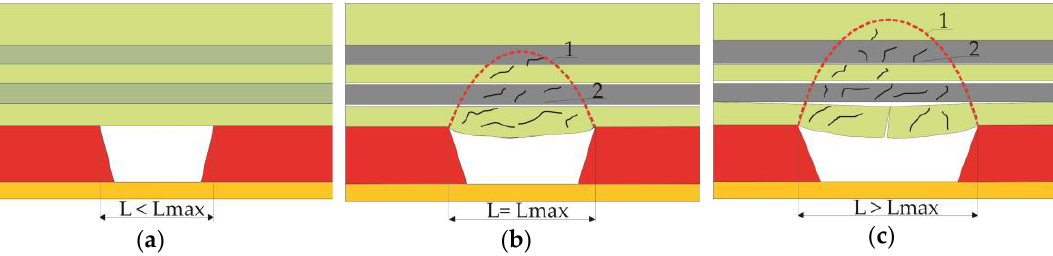
Figure 4. Behaviour of the room excavation roof as a result of moving the mining front: ( a ) Direct roof in the bed cutting phase; ( b ) Fissured and bending roof beam; ( c ) Formation of a three-hinged arch; L—room width; Lmax—maximal room width; 1—pressure vault; 2—relief stress zone.